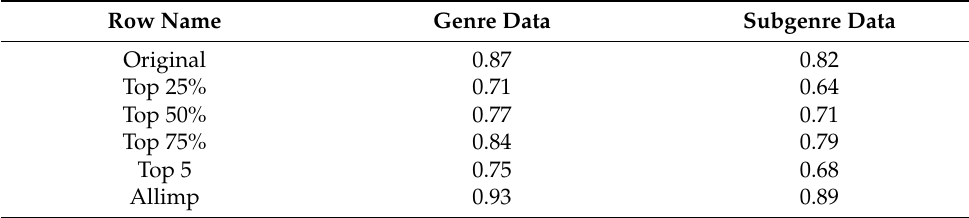
Table 9. Accuracy of the model with feature